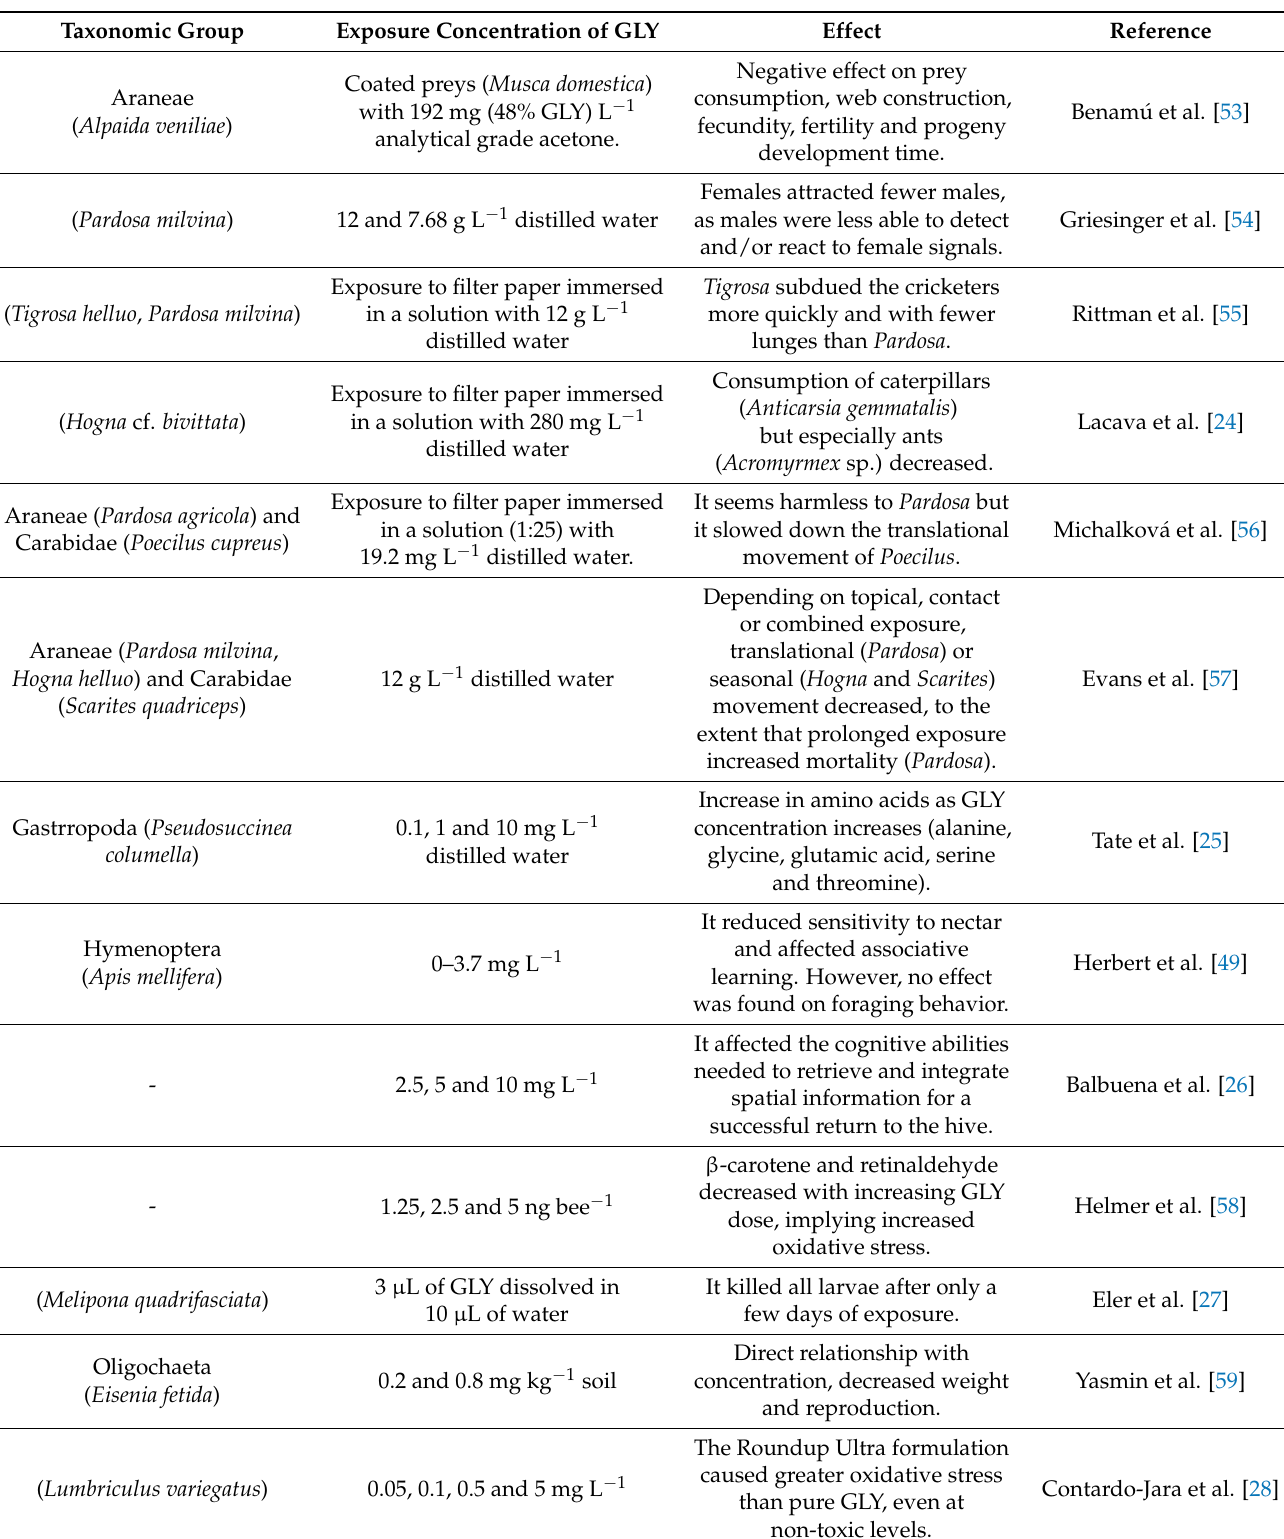
Table 2. Previous studies about the effects of glyphosate on soil